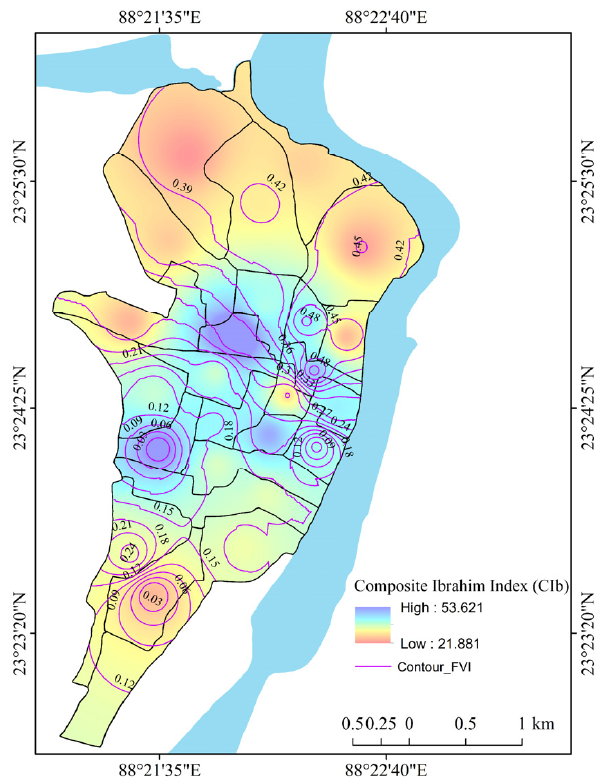
Figure 61. Comparison between ward-wise composite Ibrahim index of development and composite flood vulnerability index in Nabadwip Municipality (2015).